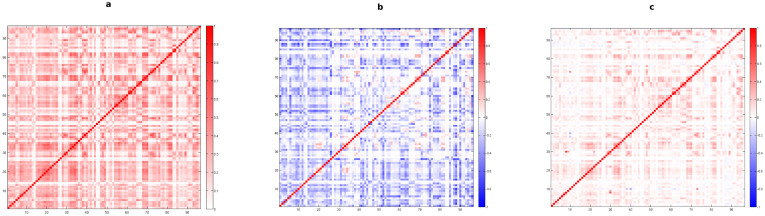
Analysis of the weighted multiplexity between layers of the International Trade Network in 2011.Color-coded matrices with entries given by mw (a), μWRG (b) and μWCM (c) for any pair of layers (commodities).